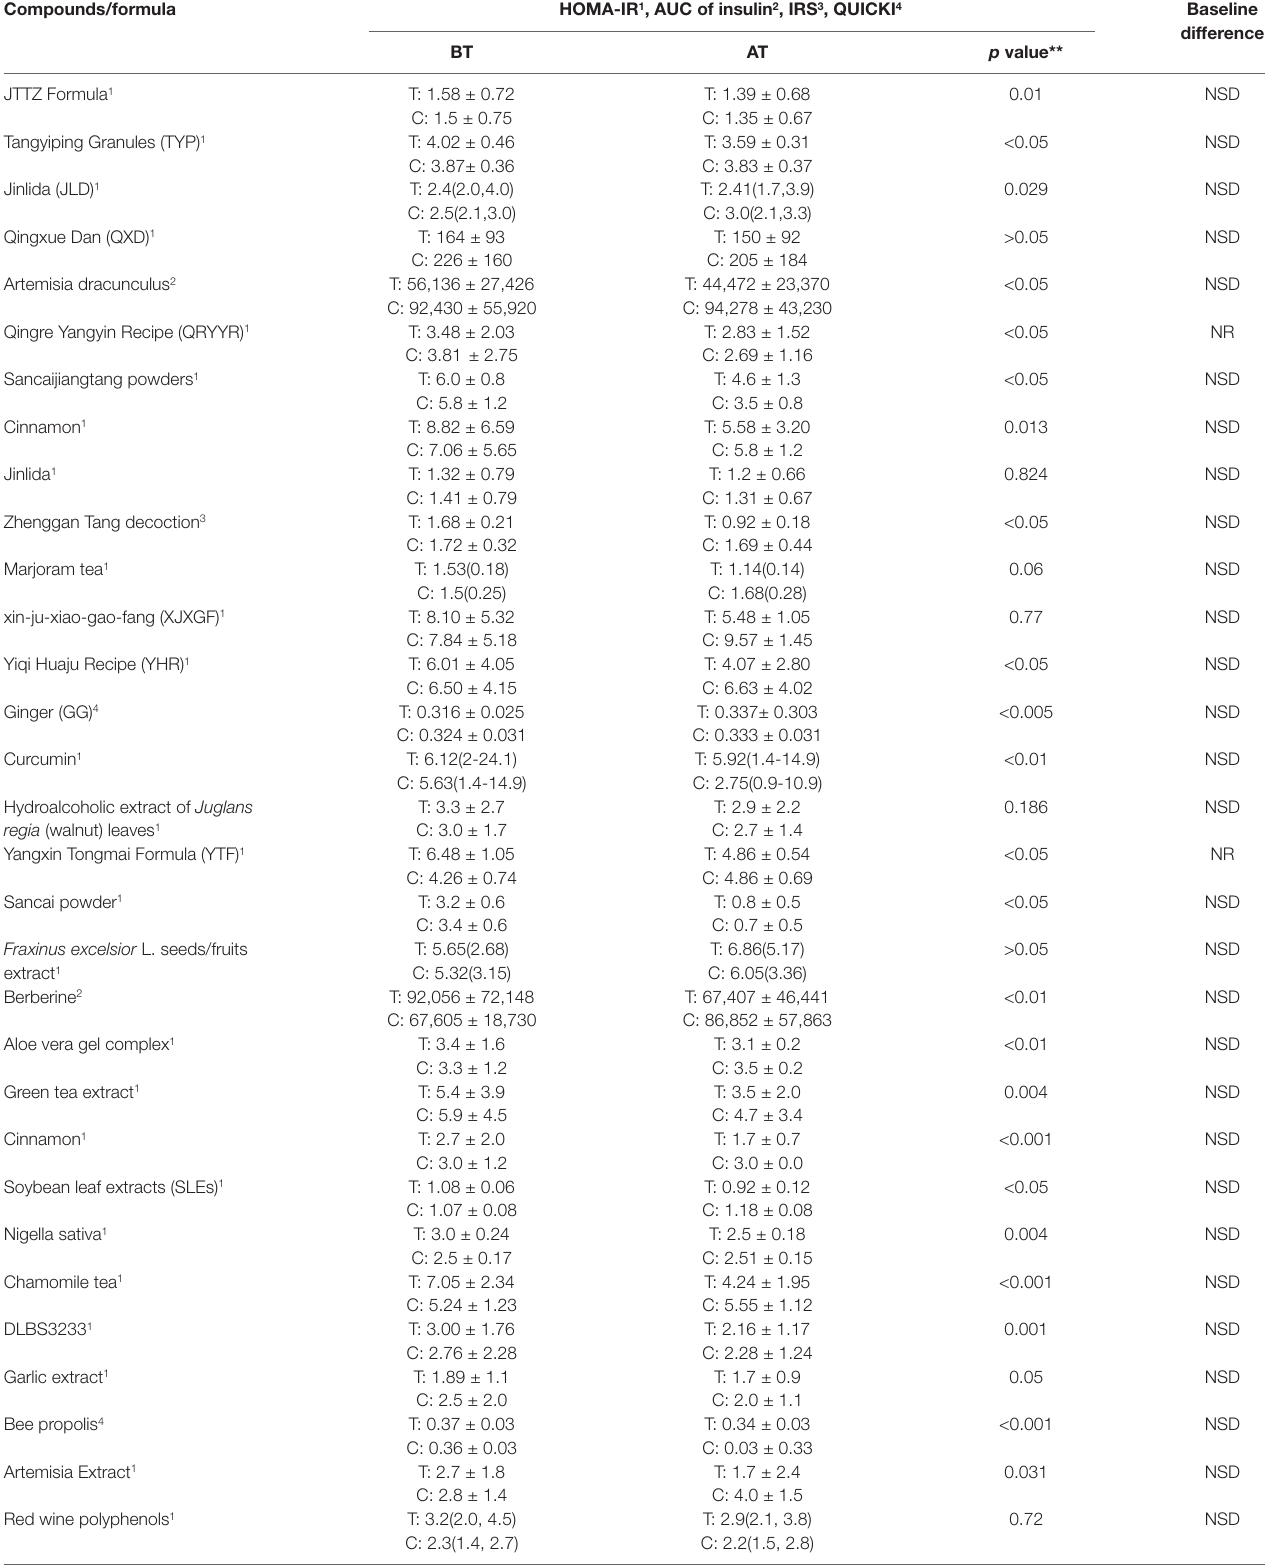
TABLE 2 | Changes in insulin resistance evaluation indicators before and after treatment in clinical trials.